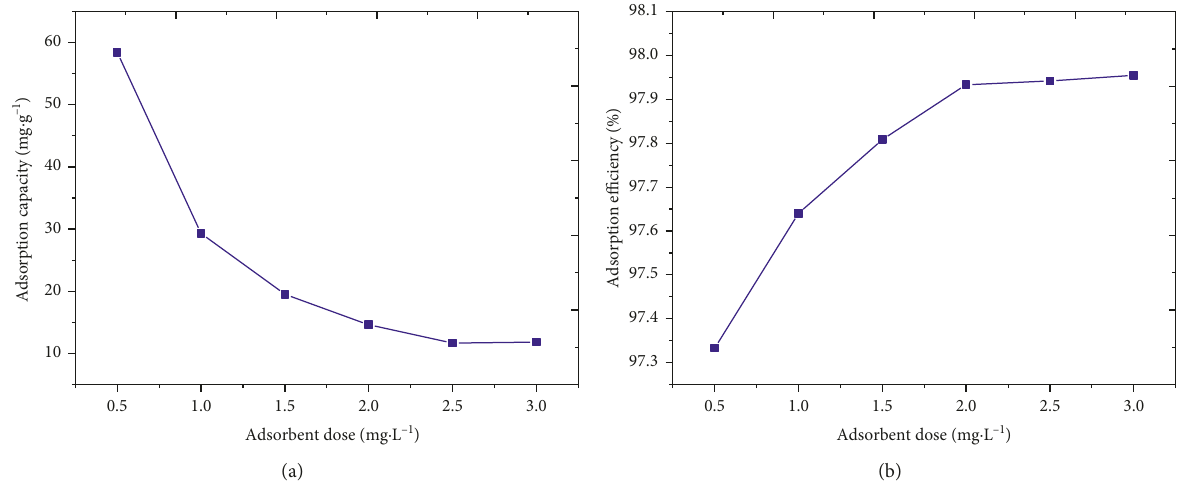
Figure 6: Effect of PB dose on (a) adsorption capacity and (b) adsorption efficiency. m � 0.5–3g · L − 1 ; [DM] � 20mg · L − 1 ; T � 20 ° C; pH � 6; V ag � 400rpm; t � 60min.